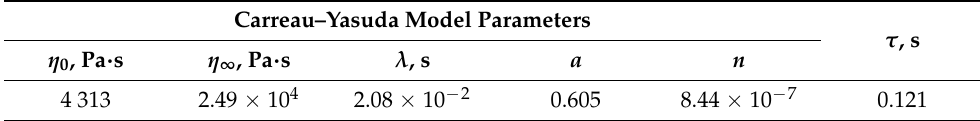
Figure 11. LV-60B ( η ∗ , G (cid:48) , G (cid:48)(cid:48) ), double-log scale; arrow indicates a first approximation of the relaxation time (0.121 s). Table 2. LV-60B: medium rheology characterization (best-fit correlation).